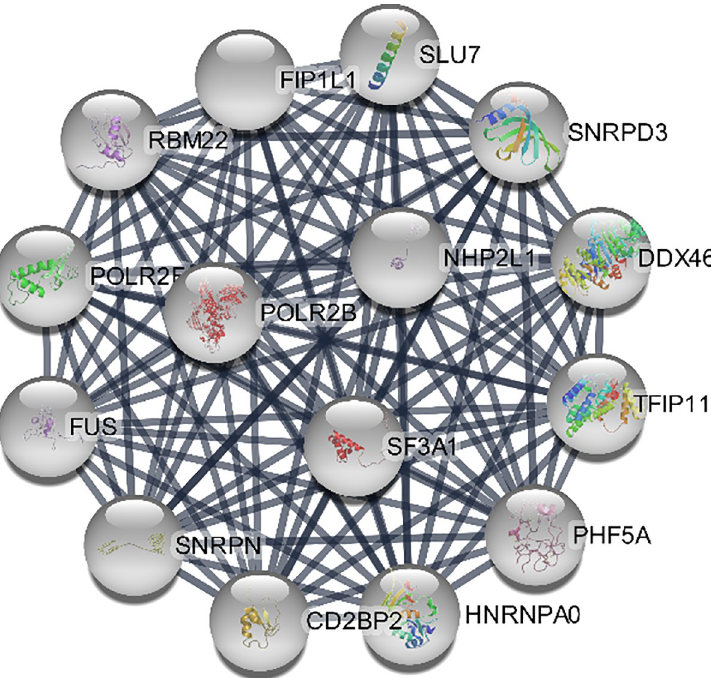
Fig 10. Cluster 2 based on MCODE analysis.